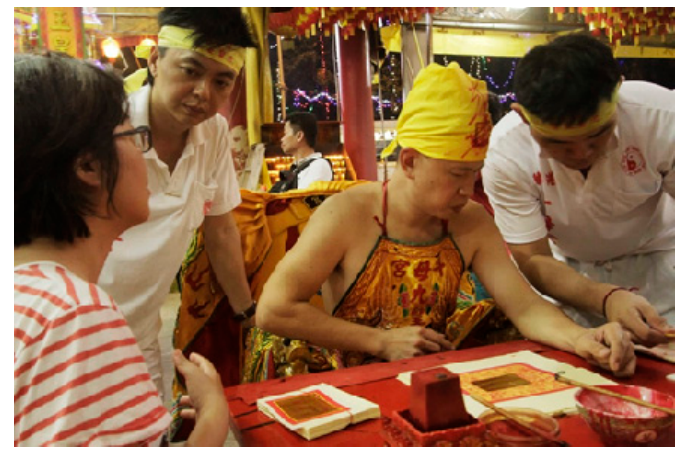
Figure 12. An Emperor God conducts a wenshi consultation with a devotee.